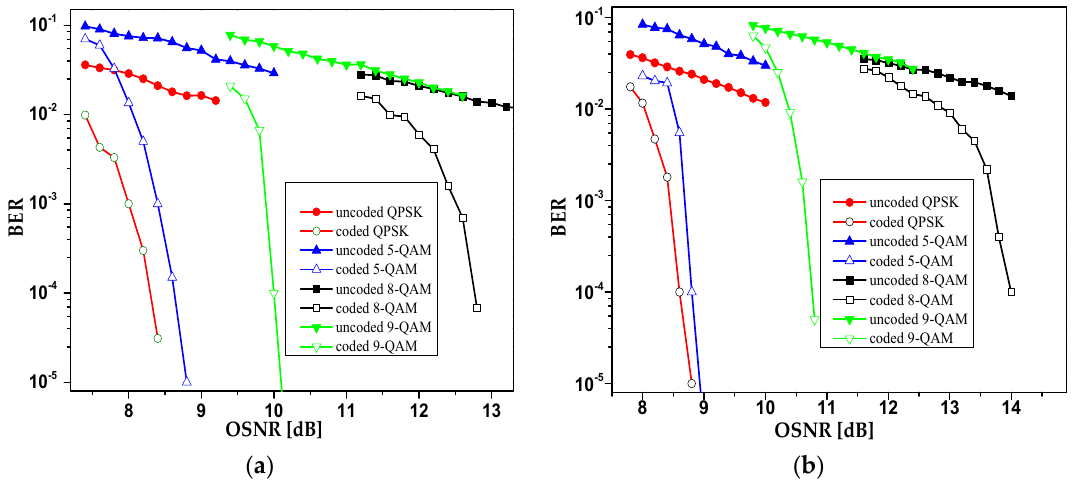
Figure 6. BER vs. OSNR performance in the atmospheric turbulence-free environment, when ( a ) OAM state 2 is under testing; ( b ) OAM state − 6 is under testing.